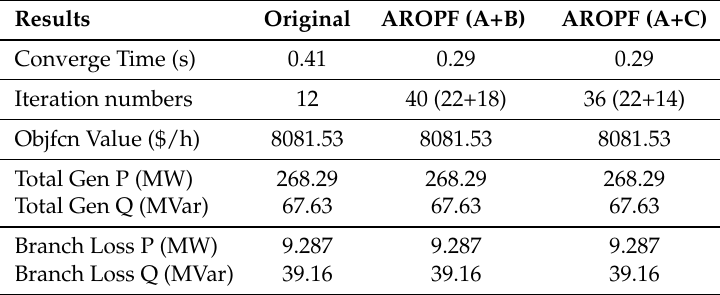
Table 3. Case 14 time cost and optimization